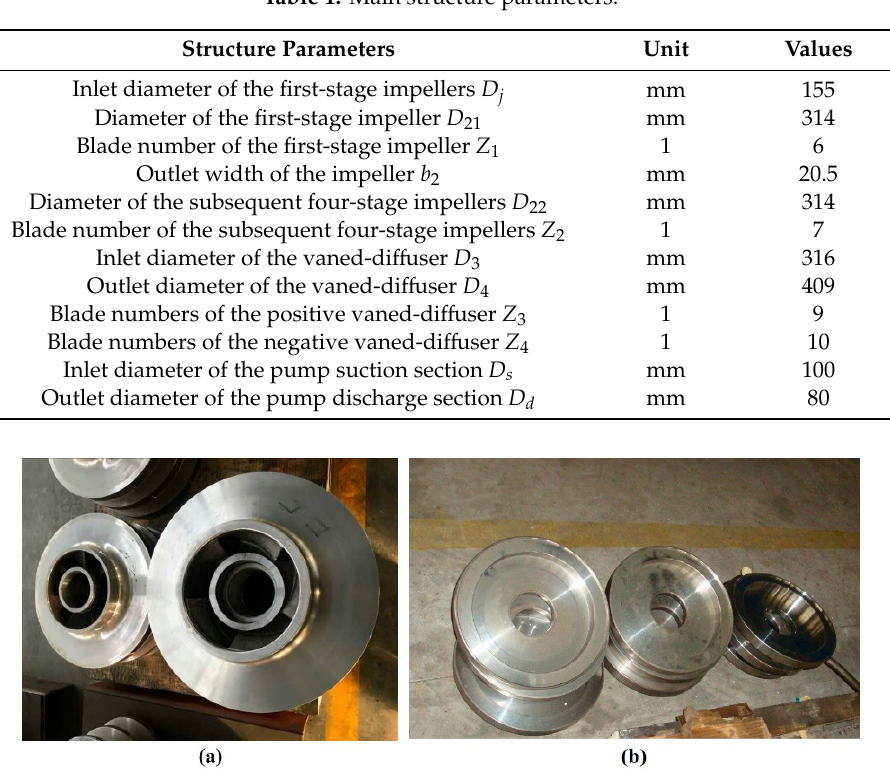
Figure 2. The main flow passage components including ( a ) the impeller and ( b ) the guide vane. Table 1. Main structure parameters.